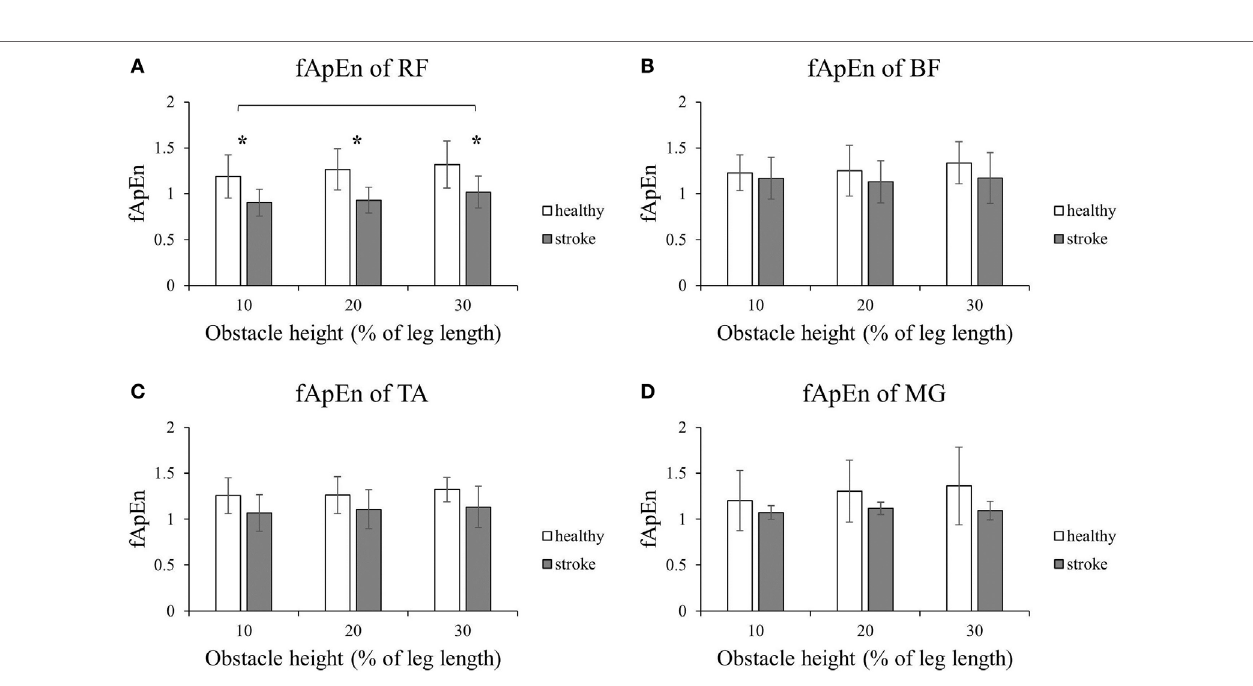
FigUre 3 | The details of fuzzy approximate entropy (fApEn) values of each height for trailing limb during swing phases. (a) The fApEn values of rectus femoris (RF); (b) the fApEn values of biceps femoris (BF). (c) The fApEn values of tibialis anterior (TA); (D) the fApEn values of medial gastrocnemius (MG). *Significant effect between groups. The bar (-) indicates significant effect between